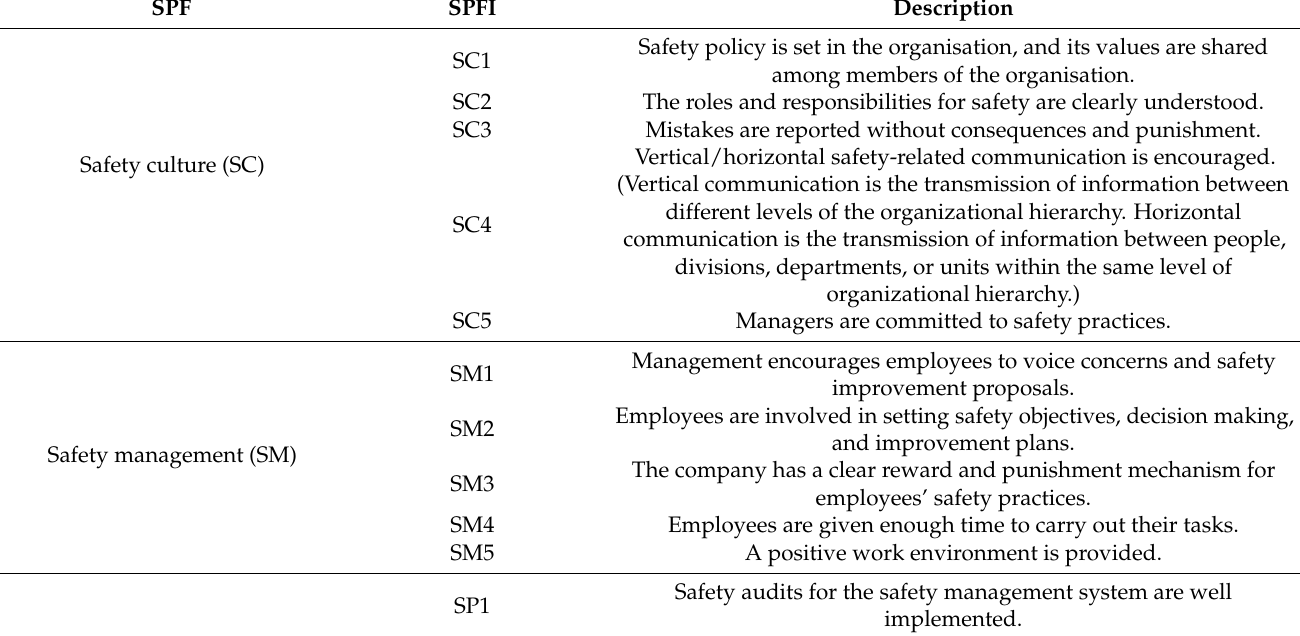
Table 3. The safety philosophical factors (SPFs) and the safety philosophical factors’ indicators (SPFIs).